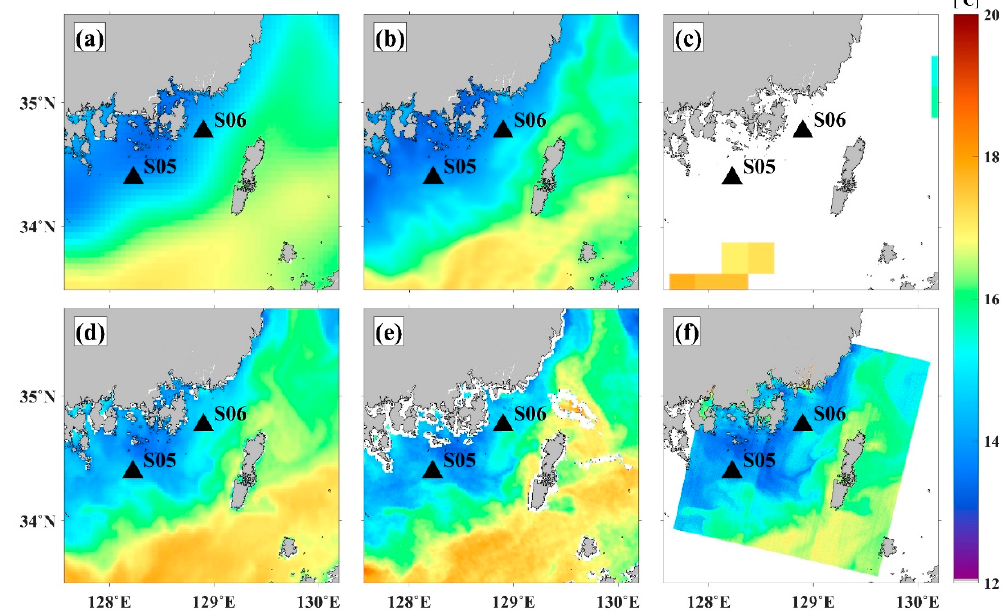
Figure 8. Distributions of SST derived from ( a ) OSTIA SST daily composite on 19 April 2016, ( b ) MURSST daily composite on 19 April 2016, ( c ) GCOM-W1 / AMSR-2 observed at 05 UTC on 19 April 2016, ( d ) Himawari-8 AHI observed at 02 UTC on 19 April 2016, ( e ) NOAA-19 AVHRR observed at 05 UTC on 19 April 2016, and ( f ) Landsat 8 OLI / TIRS observed at 02 UTC on 19 April 2016 using the NLSST5 algorithm, where the black triangles indicate the KMA buoys.